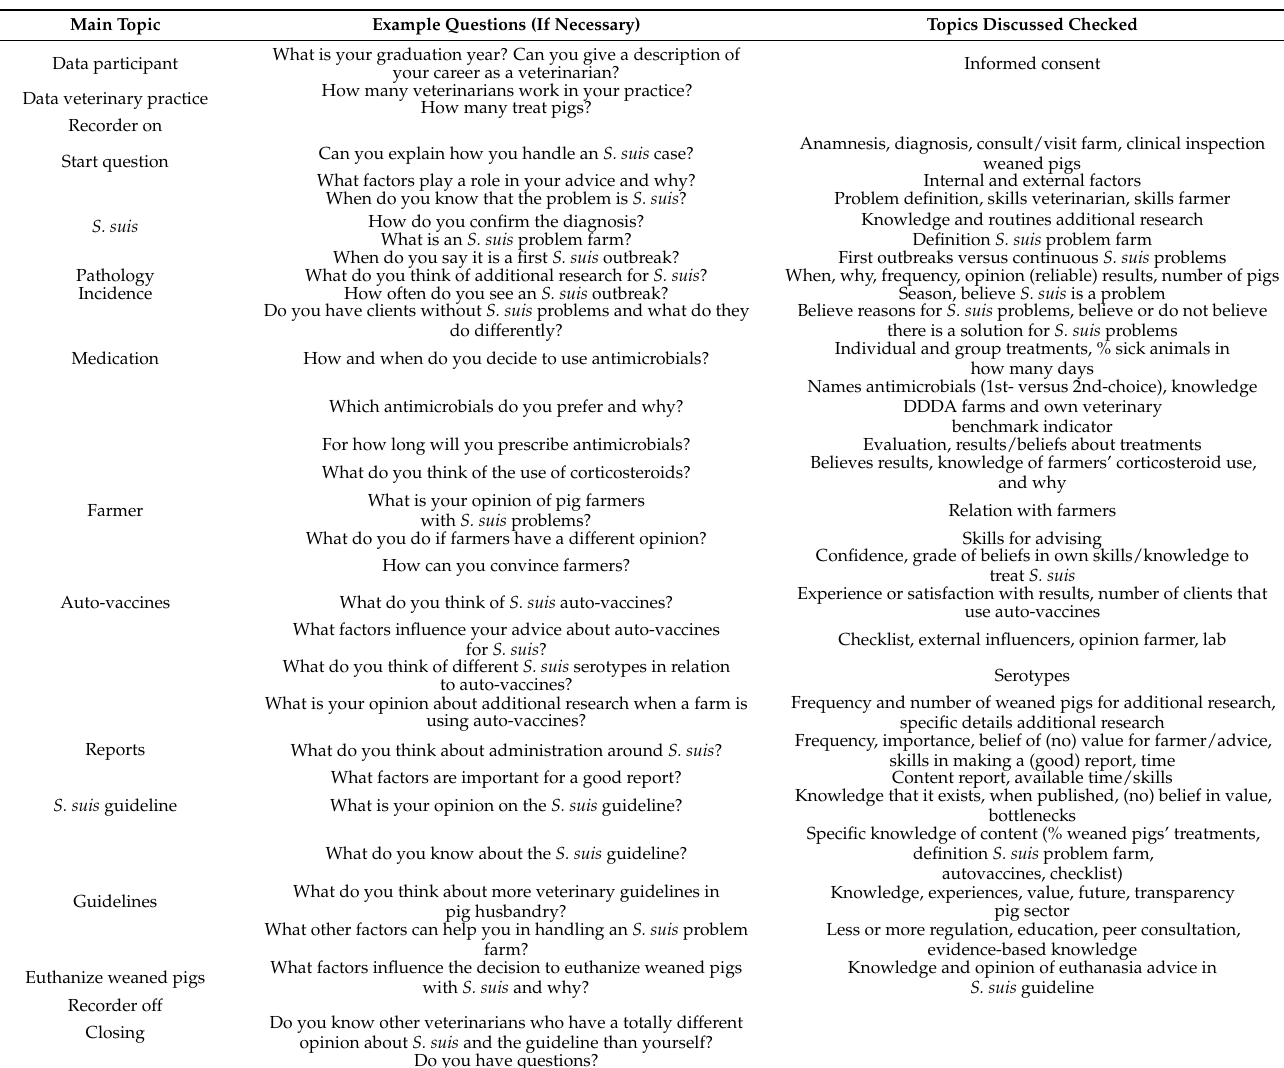
Table A1. Interview guide veterinarians in the study: “Why Veterinarians (Do Not) Adhere to the Clinical Practice Streptococcus suis (S. suis) in Weaned Pigs Guideline: A Qualitative Study”. Main research question: what factors influence the veterinarian in the decision-making process regarding adherence to the S. suis guideline? The interview guide is translated from Dutch to